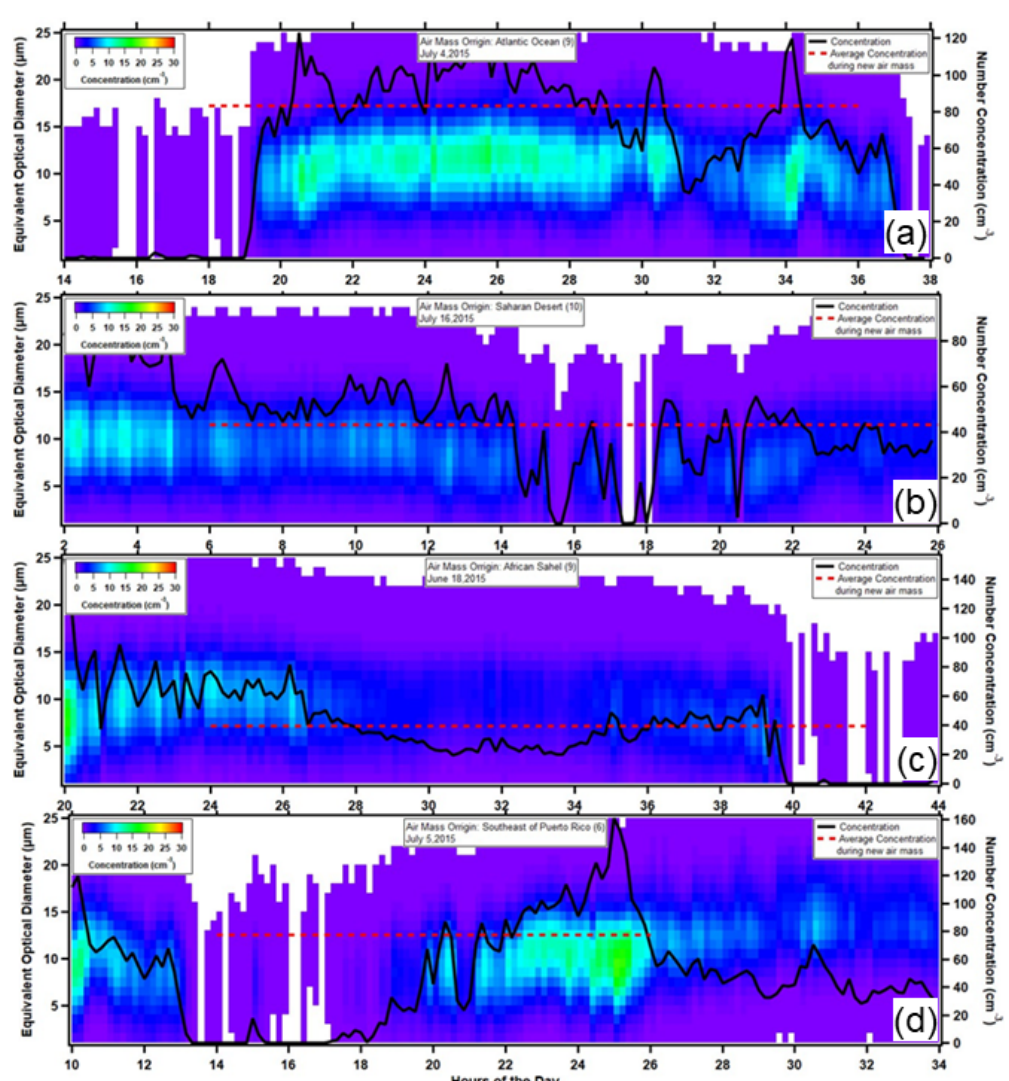
Figure 5. Time series of the size distribution of number concentrations for air masses with origins of (a) AO, (b) SD, (c) AS, and (d) SE. The color coding designates the value of the concentration. The average number concentration is drawn as the solid black curve and the red dashed line shows the period when the new air mass was